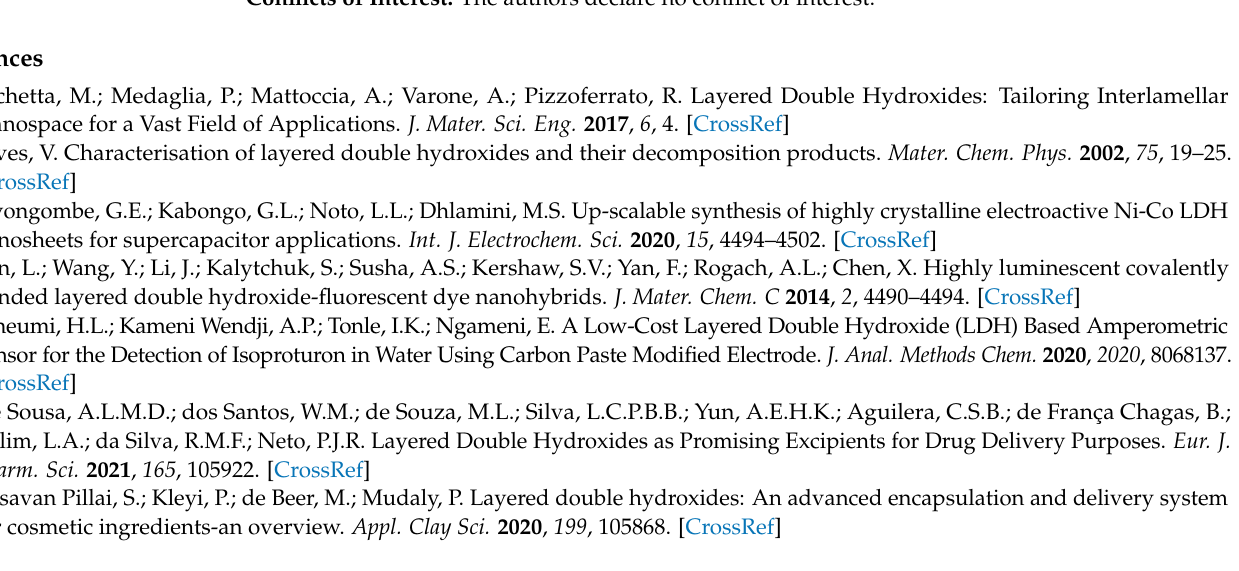
Figure S4. CV curves of (a) NiCoAl-Water, (b) NiCoAl-Ethanol, (c) NiCoAl-Acetone, (d)